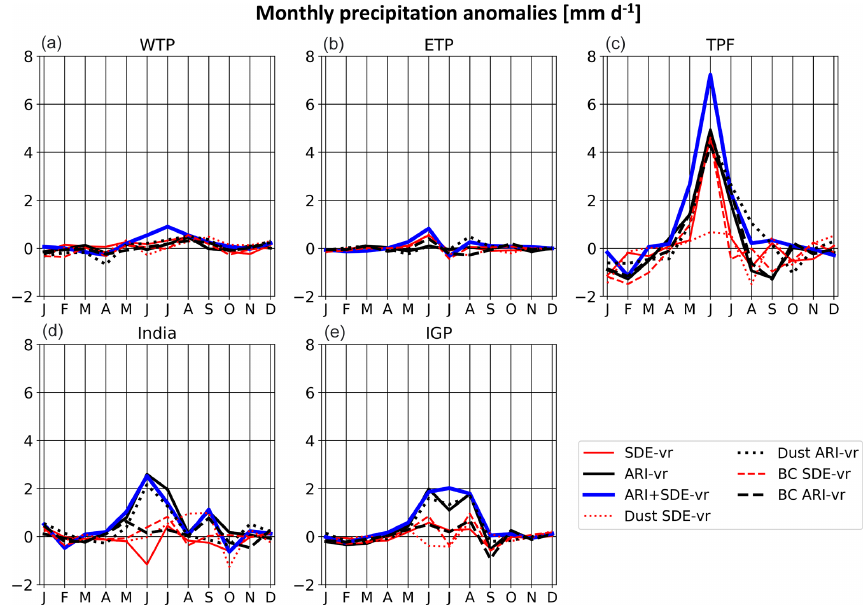
Figure 12. Same as in Fig. 9, but for precipitation rate (mmd − 1 ). Note that the y axis in (e) is different from panels (a–d) .